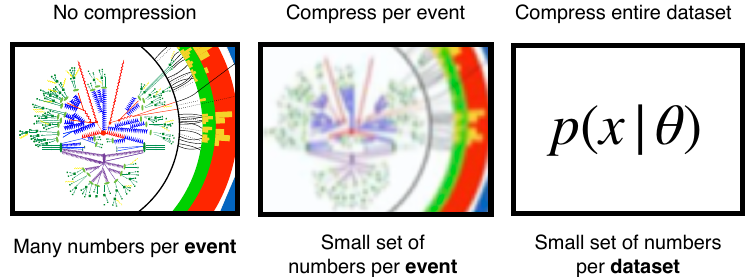
Figure 1: Illustration of data compression at the LHC. Most analyses are performed offline, based on entire events and lossless compression (left). Data scouting employs lossy compression per event (center). Our method compresses an entire data set by learning a generative model for events x in terms of network parameters θ